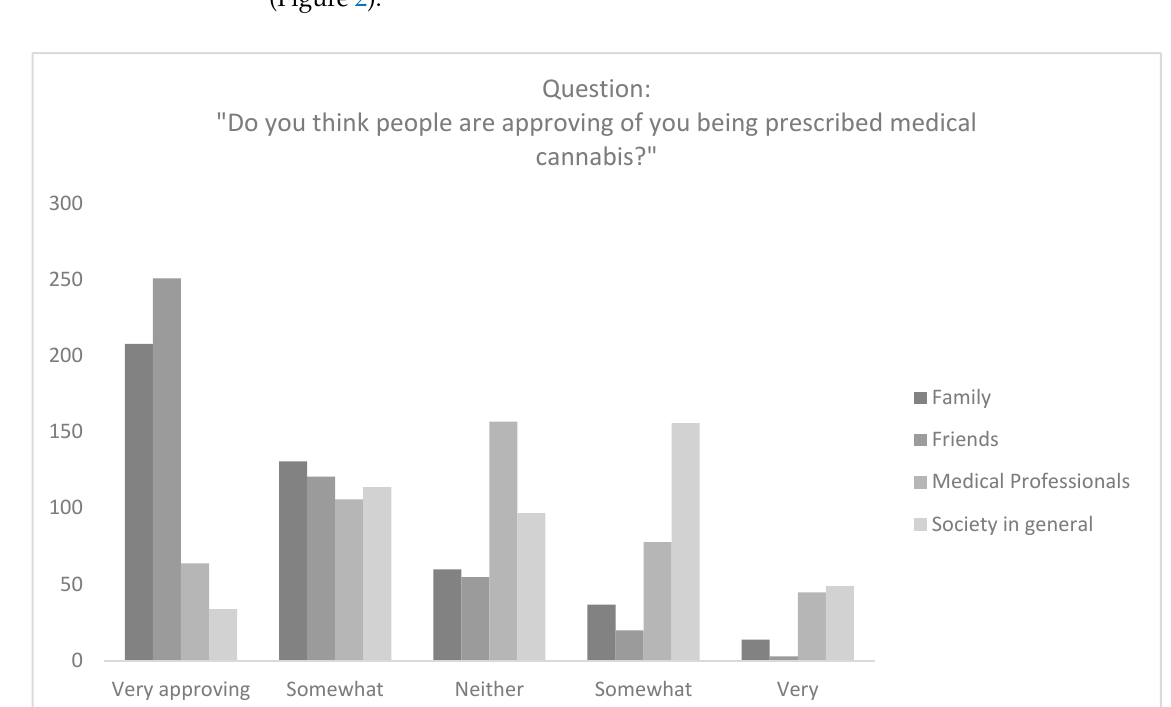
Figure 2. Raw responses to the question “Do you think people are approving of you being prescribed medical cannabis?”.